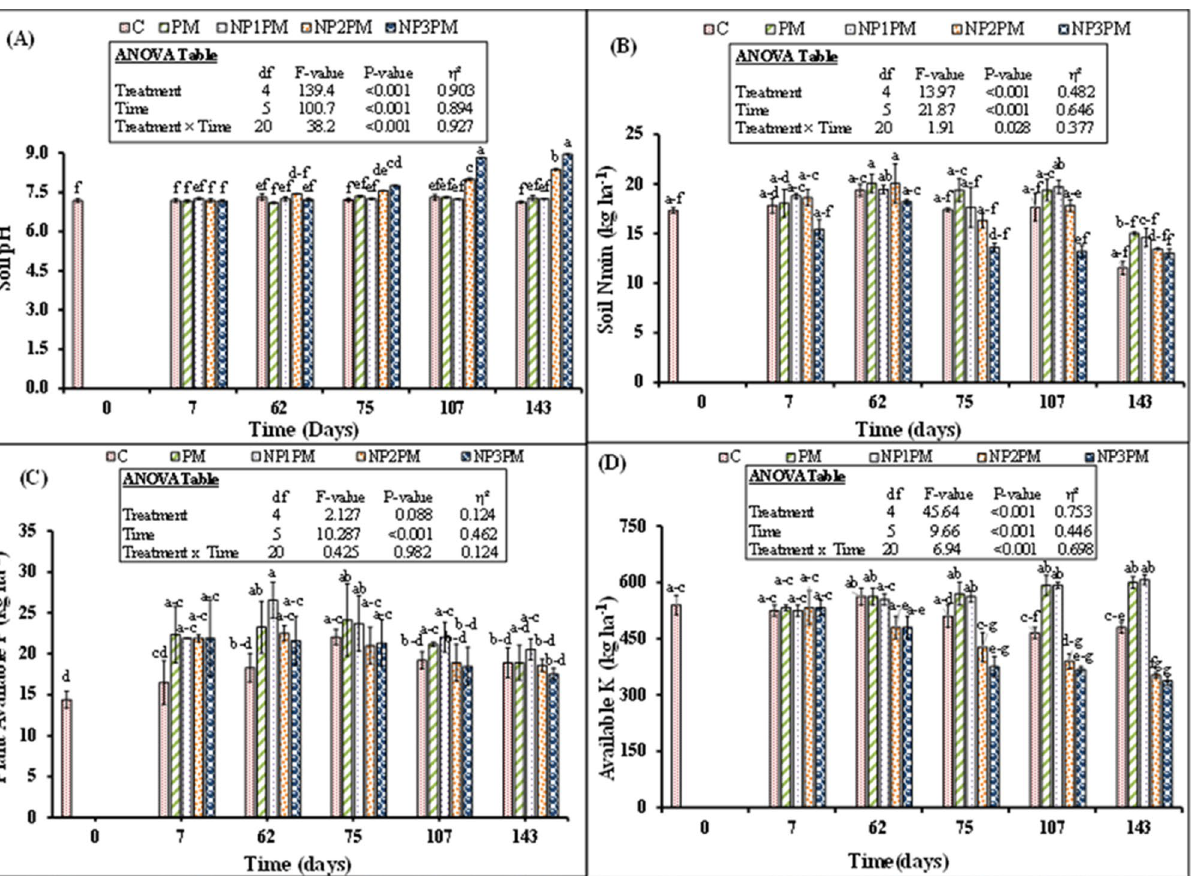
Figure 2. Mean (n = 3) soil pH ( A ), soil mineral nitrogen (Nmin) ( B ), plant available P ( C ), and plant available K ( D ) at 0, 7, 62, 75, 107 and 143 days of sowing ryegrass as affected by sole and combined application of poultry manure (PM) with nickel nanoparticles (NP). Treatments abbreviation can be found in the legend of Fig. 1. Error bars showed standard errors (± 1 SE) of the mean. Different small letters illustrated significant differences among treatments at a 5% probability level after the Tukey-HSD test. Inset table represented the outcomes of analysis of variance